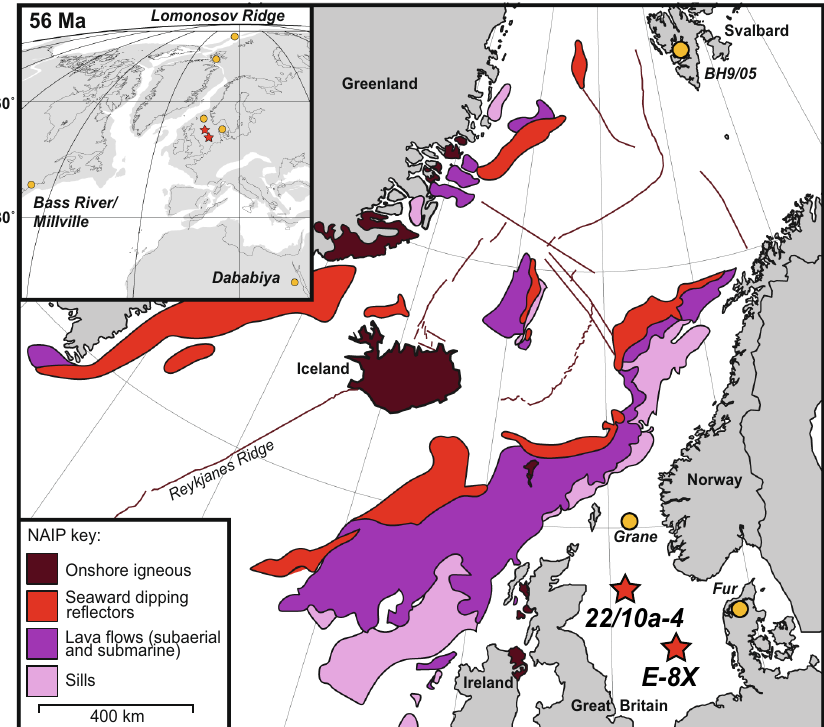
Fig. 1 Location maps of the North Atlantic Igneous Province (NAIP) and sediment cores sites analysed in this study. The simpli fi ed NAIP main map shows the estimated ranges of its various components 61 . ‘ Seaward dipping re fl ectors ’ are well-de fi ned seismic re fl ectors beneath the uppermost basalt, interpreted as large subaerial sheet lava fl ows associated with rifting 61 . Other lava fl ows are thought to be a combination of subaerial and submarine, and sills were considered as intruded into the upper crust 4,12,61 . The insert map is a Mollweid projection of modern continents (lines) on a palaeogeographic reconstruction, generated from (ref. 62 ), of continental plates (grey) centred at 56